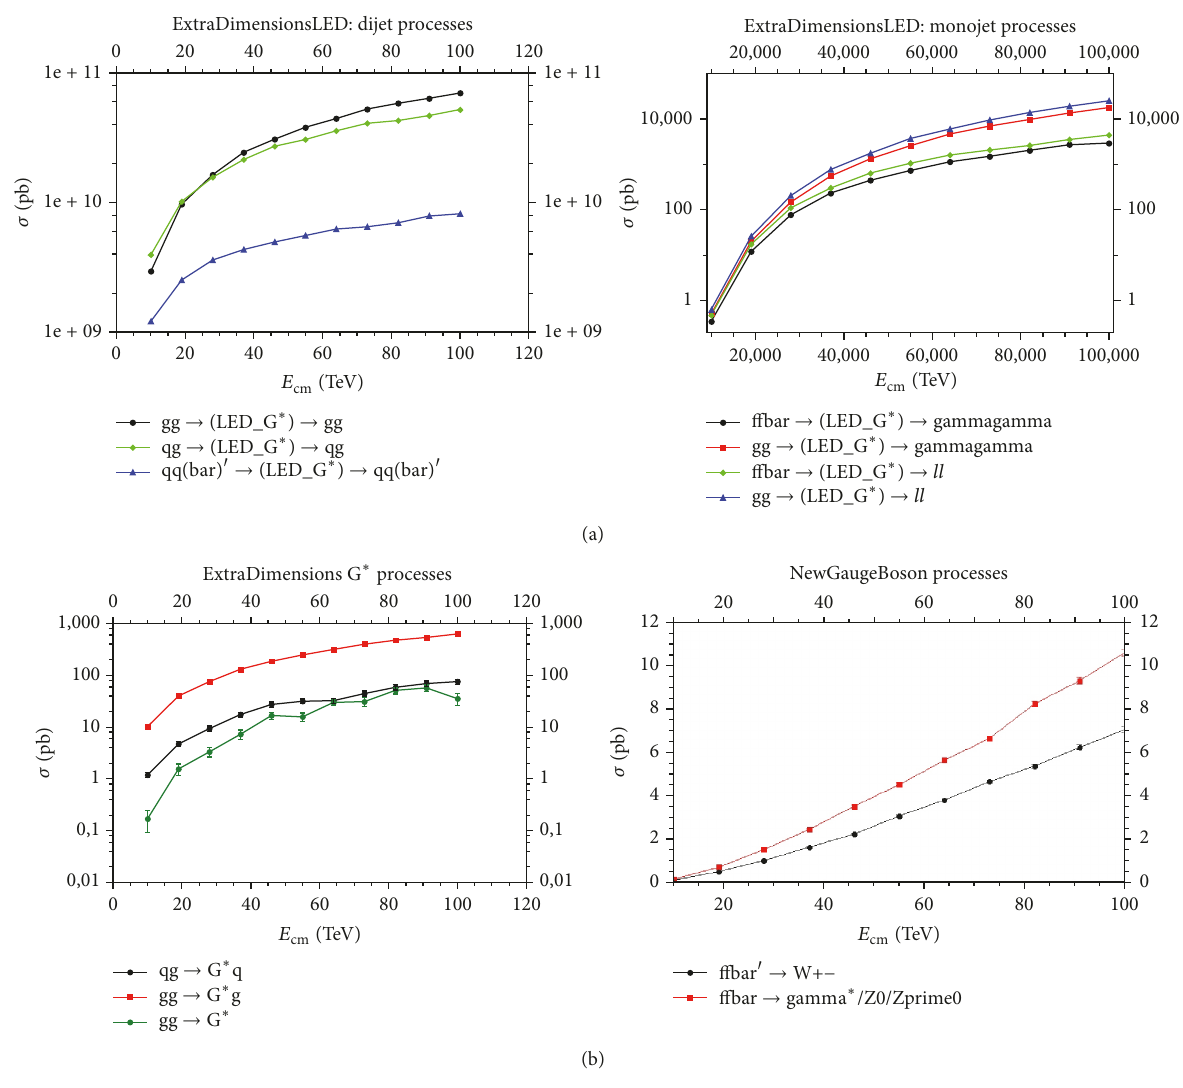
Figure 3: The production cross section at the center of mass energies varying from 14 to 100 TeV for (a) LED model: left panel, dijet final state; right panel, monojet final state; (b) left panel, RS model; right panel, TeV −1 model.